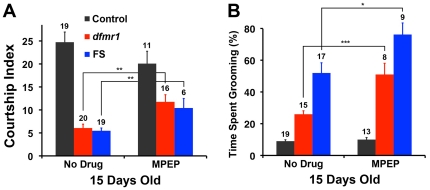
MPEP rescues courtship defects, but enhances excessive grooming in dfmr1 mutant flies.(A). Treatment of dfmr1 mutant male flies with MPEP improves courtship of naïve females. Flies were grown as larvae and maintained as adults on either control food or food containing 86 µM MPEP. Data are presented as the mean courtship index (CI, +/- SEM) with sample sizes shown above each bar. dfmr1 and FS male flies treated with MPEP engage in courtship activity with wild-type virgin females significantly more than when treated with no drug. Control flies court less when treated with MPEP, but this difference is not significant. (B). 15 day-old dfmr1 and FS flies treated with 86 µM MPEP groom significantly more than when treated with no drug. MPEP does not affect grooming activity in control flies. Data are presented as the mean percentage of time single flies spend grooming during a 5 min period (Mean +/- SEM); sample sizes are displayed above each bar. For all data, *p<0.05 and ***p<0.001 (Two-tailed students t-test).